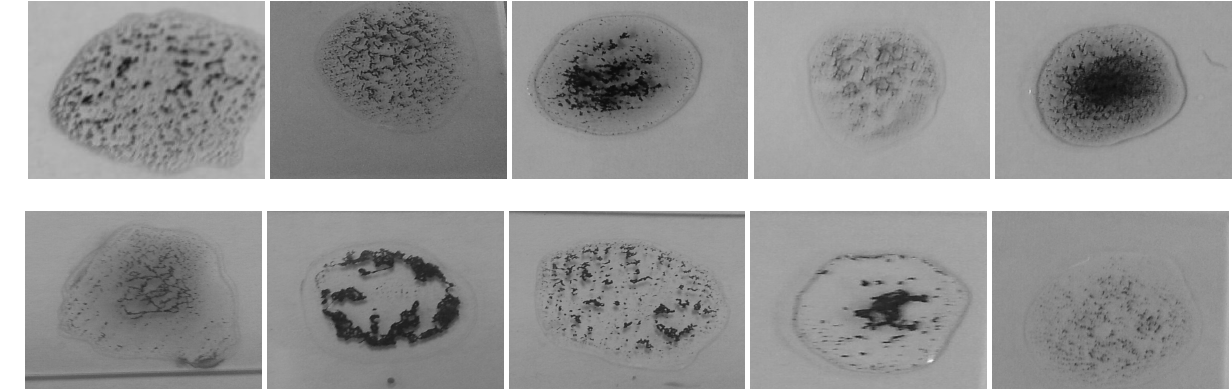
Figure 14. Samples with different agglutination patterns.